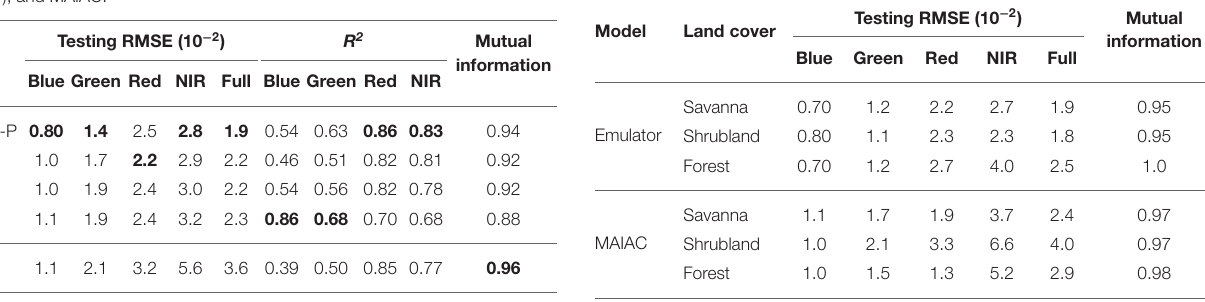
TABLE 2B | Performance metrics by band and for full spectrum for ResNet-P and MAIAC across three land cover